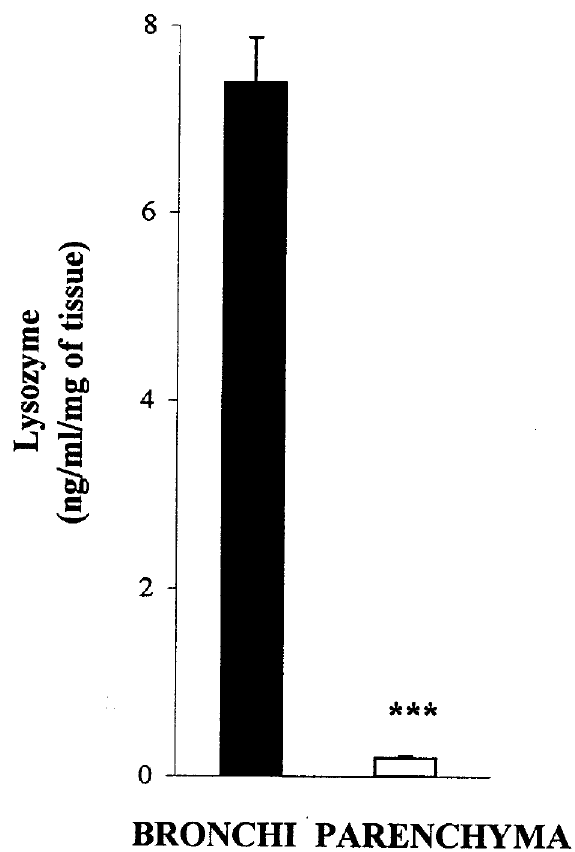
FIG. 2. Lysozyme release corrected by tissue wet weight and expressed as ng/ml/mg of tissue wet weight from human bronchial and parenchymal preparations. Values are means±SEM from 40 bronchial rings and 10 parenchymal preparations from six lung samples. ***indicates P < 0.005 (Student’s t -test).